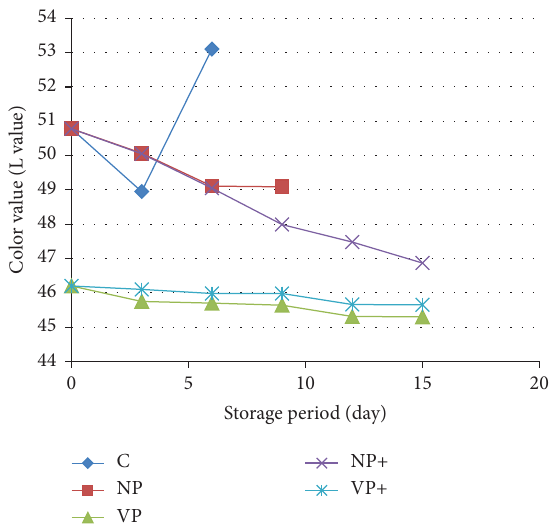
Figure 5: Colour ( L value) of injera at diferent storage intervals. For “C” and “NP” treatments, the experiment was terminated at 6 th and 9 th day of storage, respectively, since the samples were spoiled.